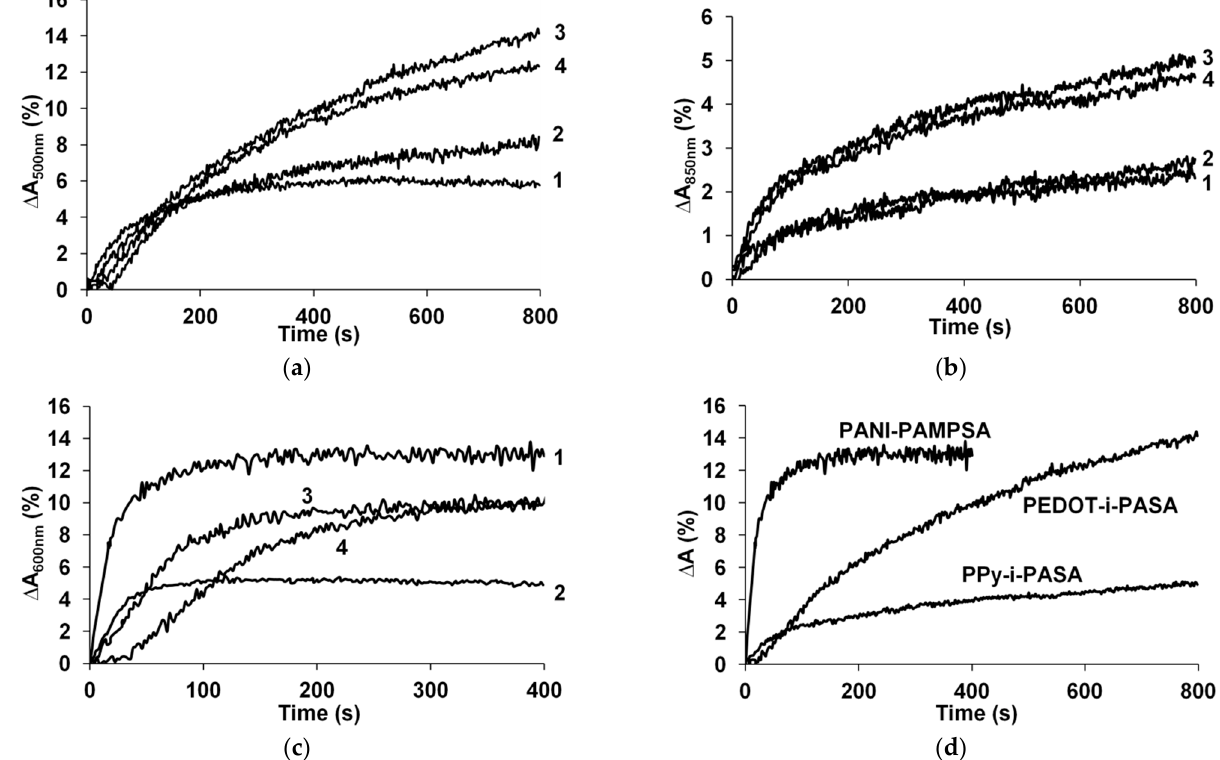
Figure 3. The responses of PEDOT ( a ), PPy ( b ) and PANI ( c ) films prepared in 1-PAMPSA, 2-PSSA, 3-i-PASA and 4-t-PASA exposed to 52 ppm NH 3 . Comparison of the responses of the best CP complexes exposed to 52 ppm NH 3 ( d ).